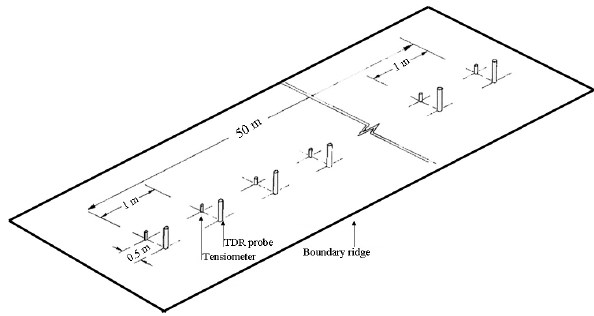
Fig. 1. View of the experimental plot displaying relative position of TDR probes and 0.3m depth